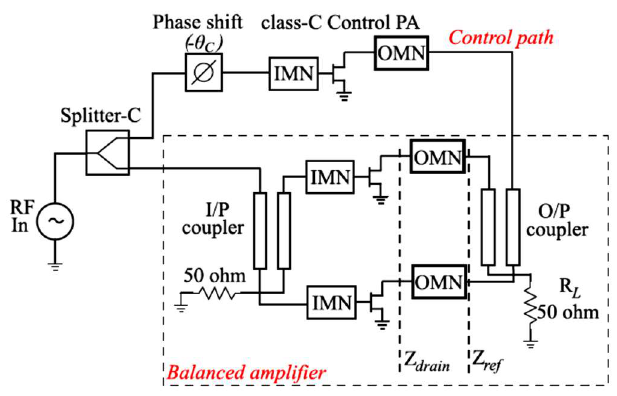
Figure 22. Simplified schematic of the RF-input load modulation balanced amplifier. [121].